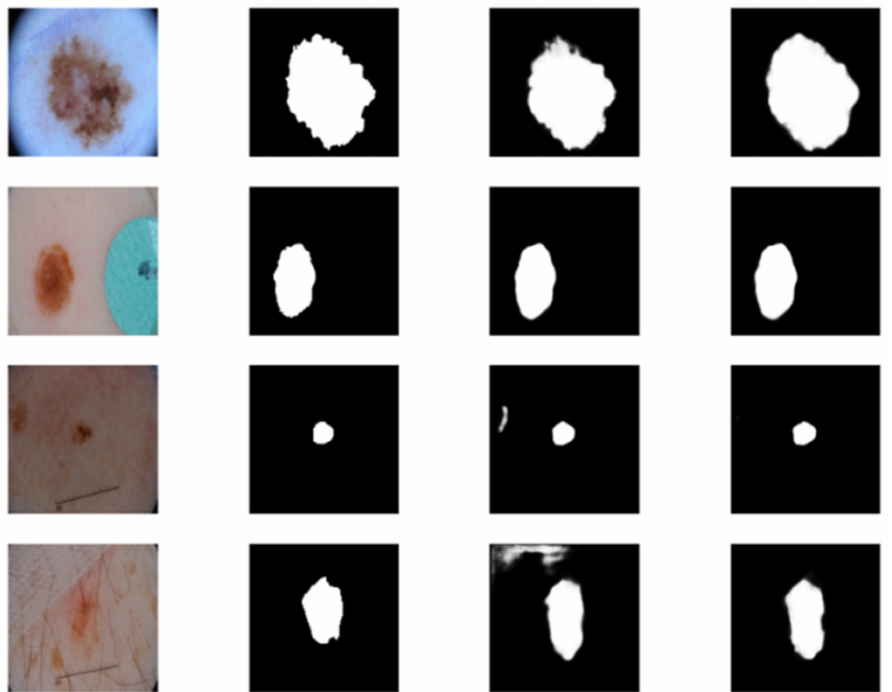
Figure 11. Qualitative assessment of UNet++ and Residual-Attention UNet++ performance on skin cancer. First column: original image, second column: ground truth, third column: UNet++’s output, last column: Residual-Attention UNet++’s output.